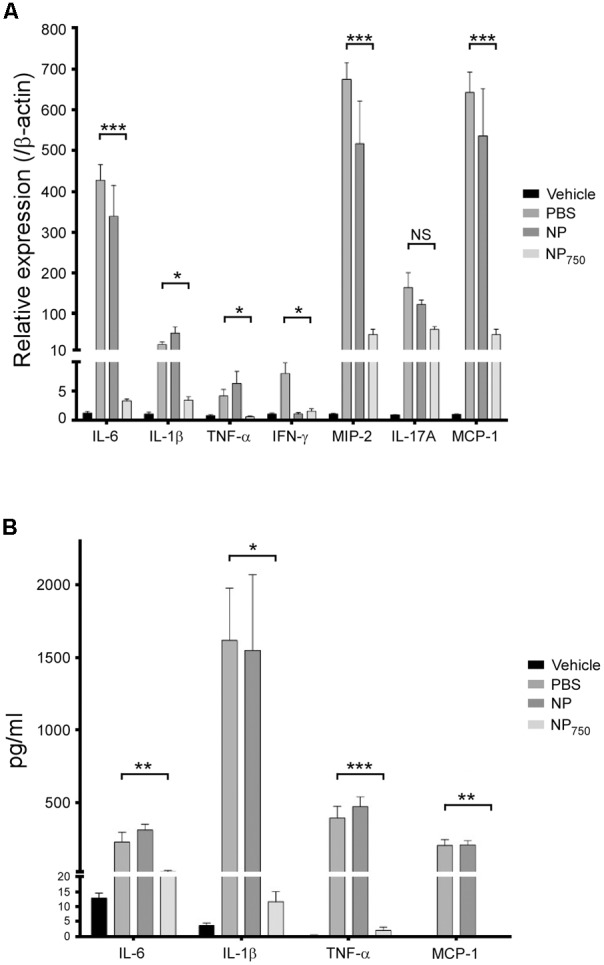
Decreased level of proinflammatory cytokines in C. difficile-infected mice vaccinated by NP-rTcdB. The level of various proinflammatory cytokines and chemokines in colon tissues (A) and GAL (B) of vehicle group, mock-vaccinated group (PBS), empty nanoparticle-vaccinated group, and NP750 vaccinated group as measured by real-time polymerase chain reactions and ELISA, respectively. All data are presented as mean ± standard deviations and statistical comparisons among groups were analyzed by Student’s t-test (∗p ≤ 0.05, ∗∗p ≤ 0.01, ∗∗∗p ≤ 0.001, ∗∗∗∗p ≤ 0.0001). NS, not significant. All data are representative of at least three independent experiments.